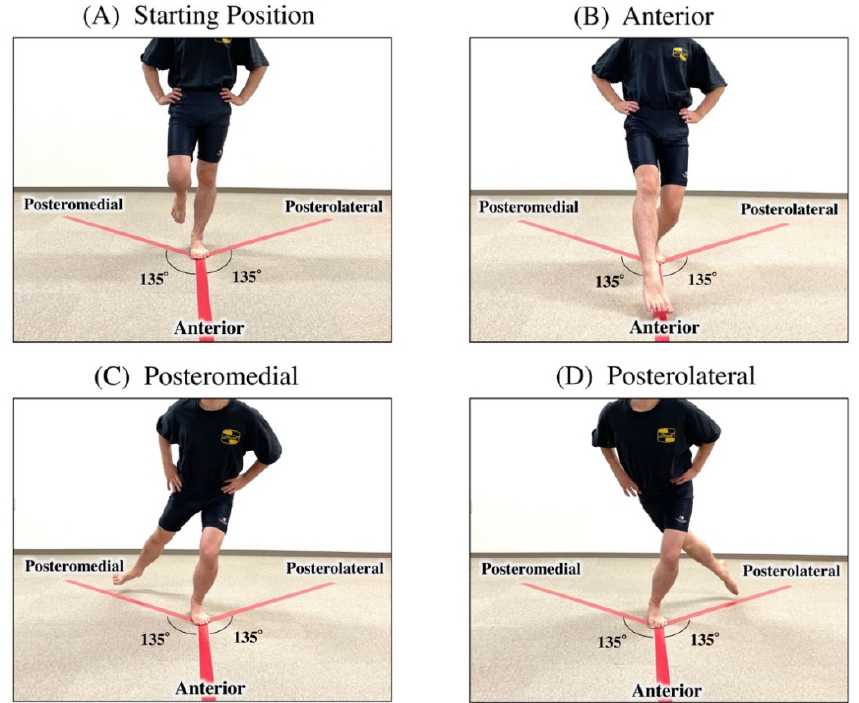
Figure 1. Modified Star Excursion Balance Test (mSEBT). Start position ( A ). Participants stand on their dominant or nondominant leg in the center of three grid lines, with their hands placed on the lower rib cage. All participants were instructed to keep their balance and to reach towards the other leg as far as possible in the anterior ( B ), posteromedial ( C ), and posterolateral directions ( D ). Finally, they touched the floor with their toes.